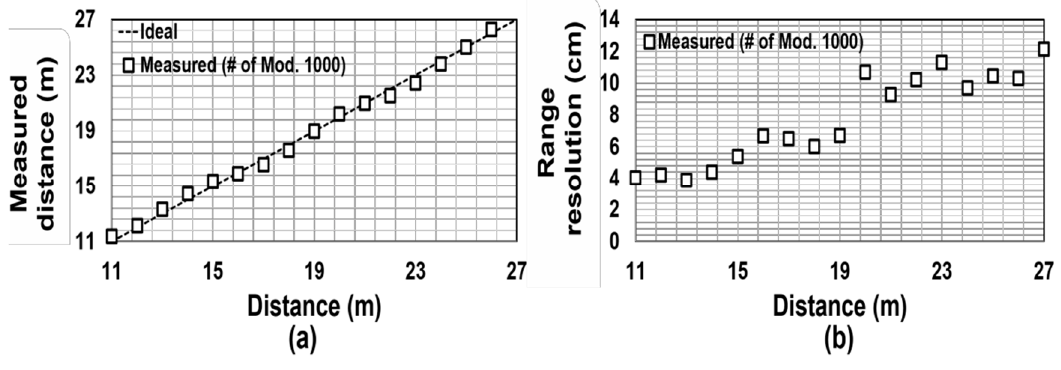
Figure 5. Measured ( a ) distance and ( b ) range resolution in